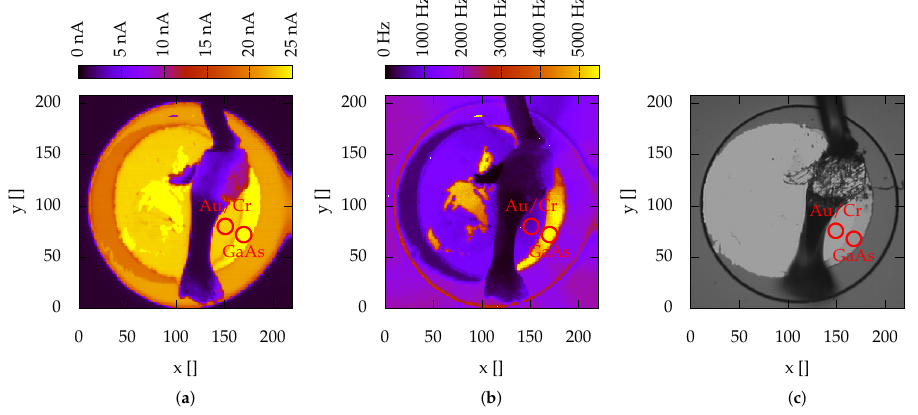
Figure 7. ( a ) Photocurrent map; ( b ) X-ray fluorescence image of the As L α line; ( c ) microscope optical image of the device. Regions of higher intensities correspond to the unexposed half-moon shaped areas of the devices, which are clearly visible in all three images. For each of the analysed devices, photocurrent maps and X-ray fluorescence maps were acquired at different soft-X-ray photon energies at the TwinMic beamline [ ? ]. Rep-